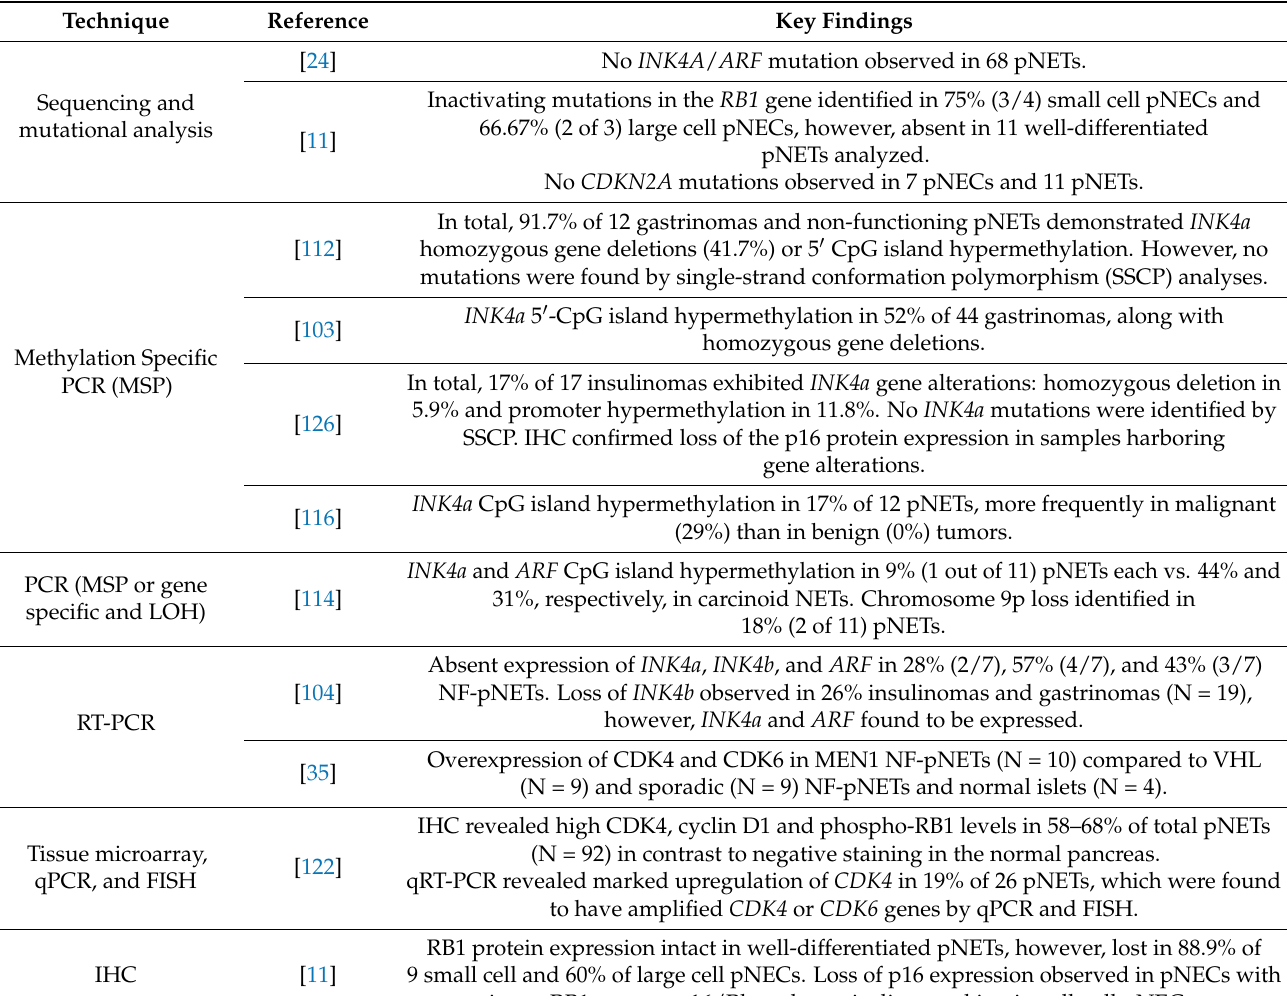
Table 4. Molecular profiling studies revealing INK4a/ARF and RB1 pathway alterations in